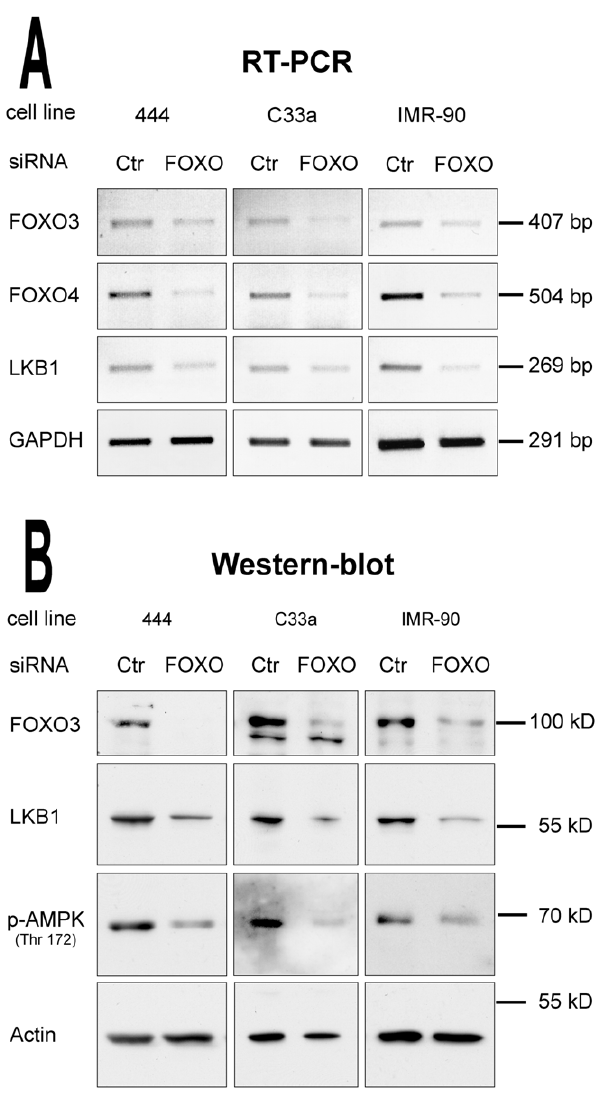
Figure 9. FOXO transcription factors are required for LKB1 gene expression. Knockdown of endogenous FOXO3 and FOXO4 in ‘‘444’’, C33a and IMR-90 cells. Cells were transfected either with scrambled siRNA (Ctr) or with a siRNA targeting all FOXO family members (FOXO). Total RNA was purified and relative mRNA levels of FOXO3, FOXO4, LKB1 and GAPDH were analysed by RT-PCR using ethidium bromide staining ( A ). Equal amounts of total protein (5 m g) were separated by SDS-PAGE and analysed by western blotting using antibodies against FOXO3, LKB1 phospho-AMPK (Thr172) and actin ( B ). The data shown is representative of three independent experiments. GCCCACGGACAAGTATGAAC-3 9 ) with Phusion High-Fideli- ty DNA-polymerase (Finnzymes) according to the manufacturer’s instructions. Deletion mutants were generated by PCR using primers listed in Table S1 and inserted into the SmaI site of the pGL3-Basic plasmid. Substitution mutants of the LKB1 promoter were derived from the deletion mutants by inserting a second PCR product expanding from 2 549 to the deletion end point, using an upstream primer containing a SacI site and the 2 549 sequence and downstream primers containing a NheI site and the sequence adjacent to the respective deletion end point (Table S1).